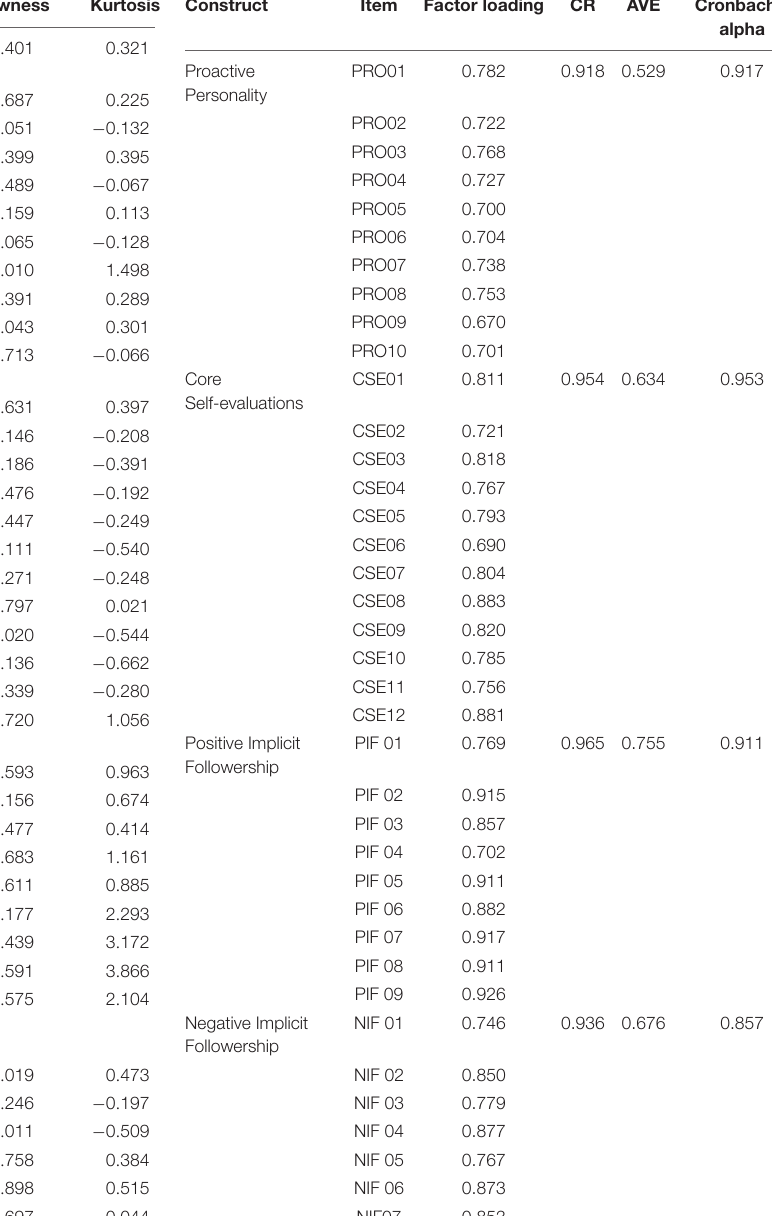
TABLE 2 | Results of reliability and validity analysis. TABLE 3 | Results of reliability and validity analysis.